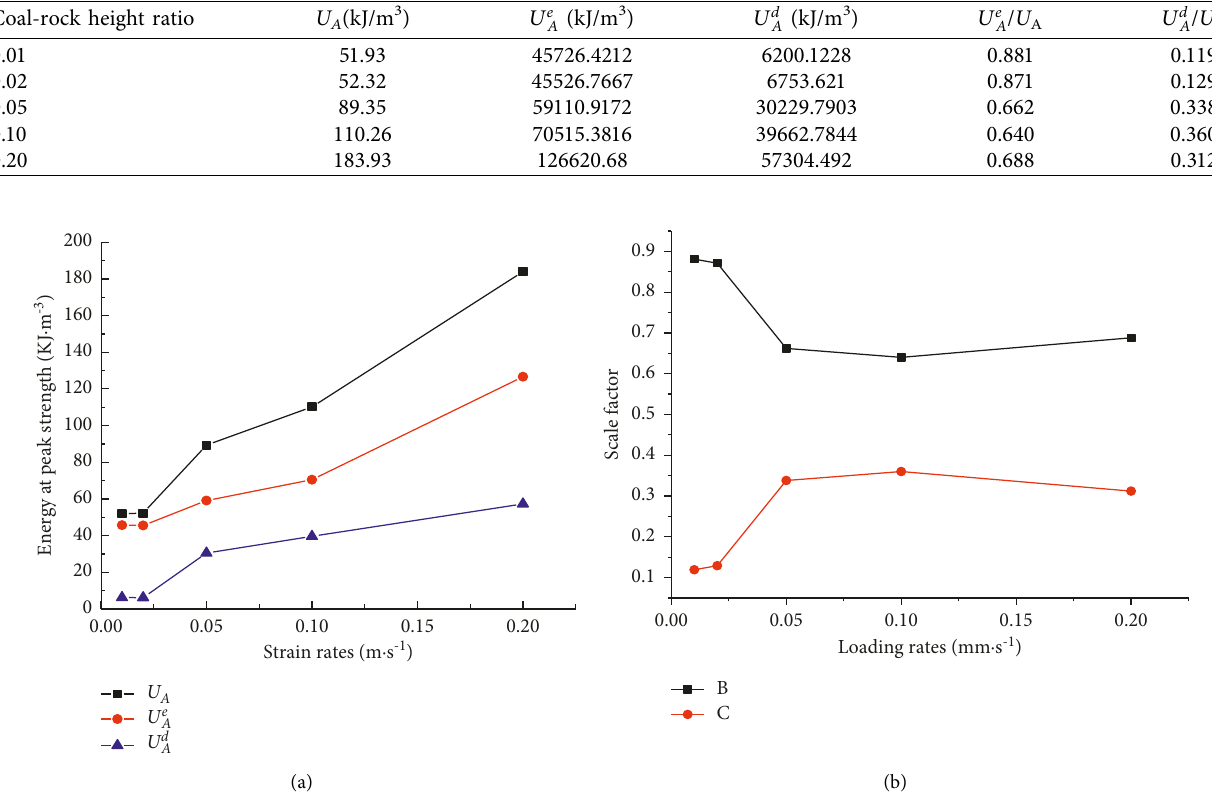
U e A , and dissipated energy